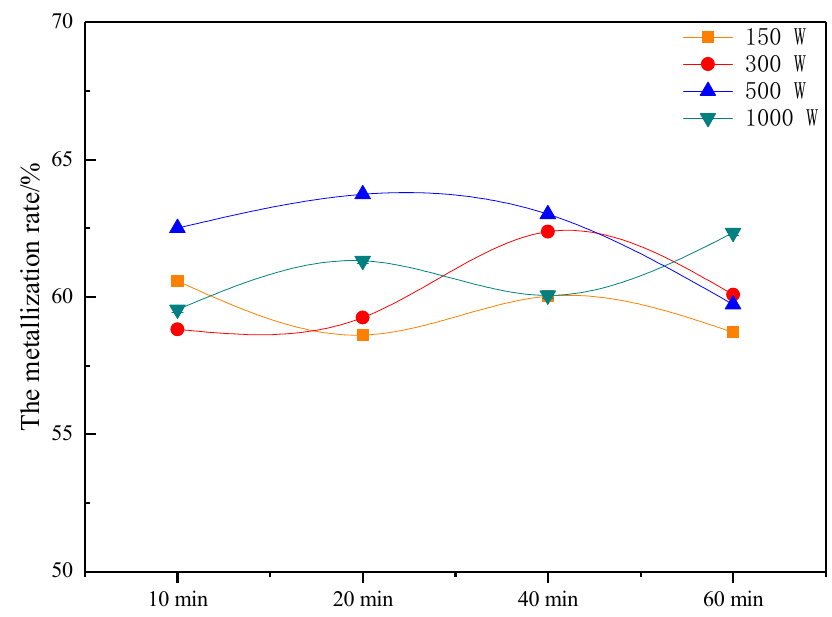
bond ratio significantly decreased. To more intuitively reflect this change, the obtained results are plotted in Figures 4–6.